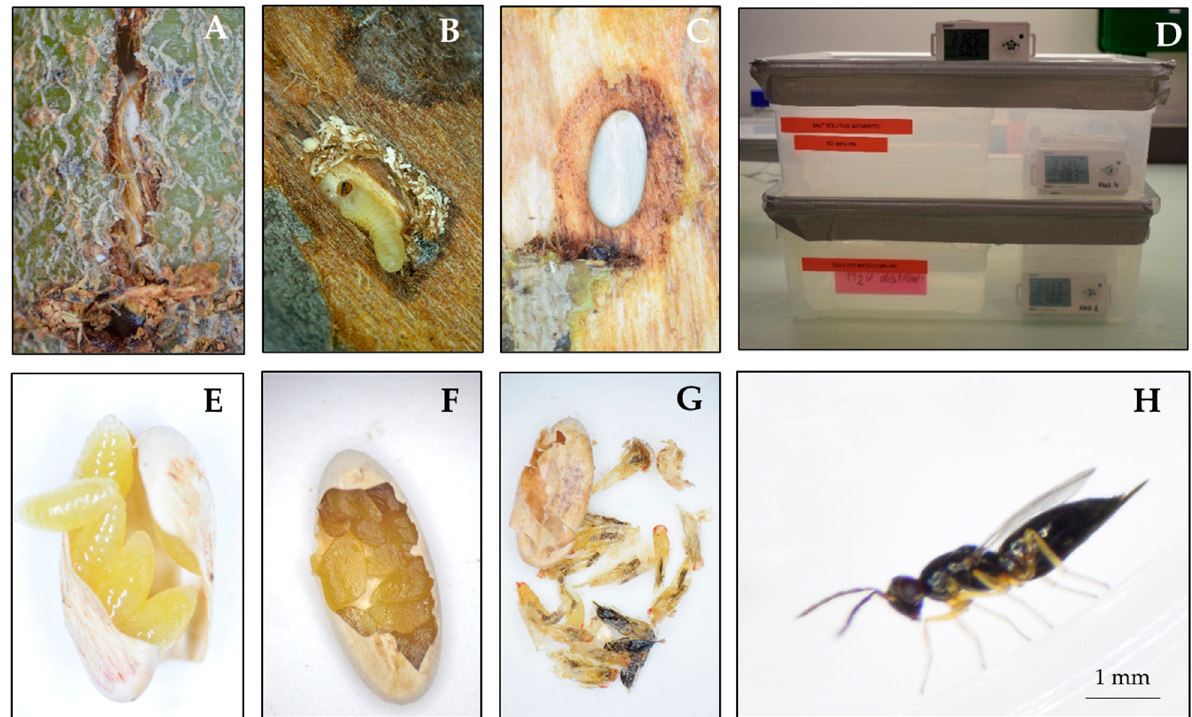
Figure 1. Laboratory rearing of the parasitoid A. fukutai : ( A ) T-shaped oviposition scar of A. chinensis in a Salix log containing an egg which was exposed to the parasitoid for parasitization, ( B ) an unparasitized egg (hatched with sawdust from larval feeding), ( C ) a parasitized egg (swollen) containing mature parasitoid larvae, ( D ) excised parasitized eggs placed in 24-well cell culture plates inside a humidity box, ( E ) heathy parasitoid larvae, ( F ) dead parasitoid larvae after diapause, ( G ) dead parasitoid pupae and unemerged adults after diapause, and ( H ) an emerged adult female parasitoid.